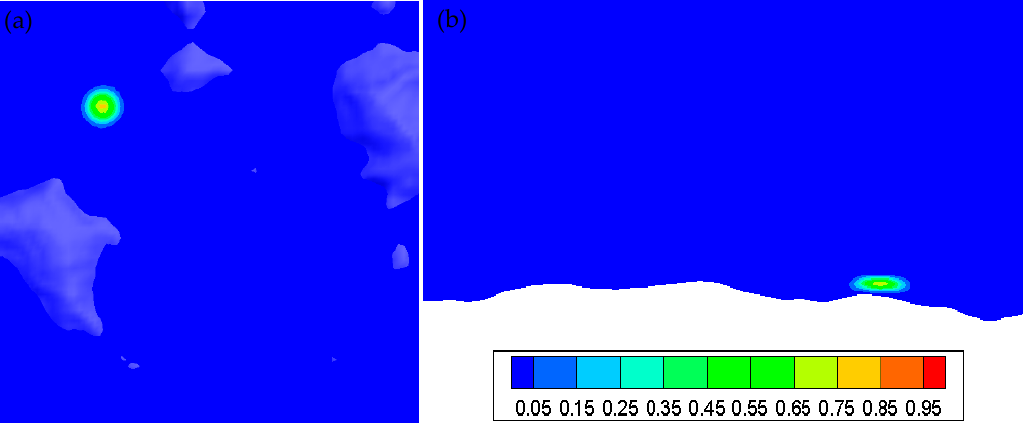
Figure 12. Contour map of the Cressman weighting function at an observed point: ( a ) horizontal cross-section; ( b ) vertical cross-section.